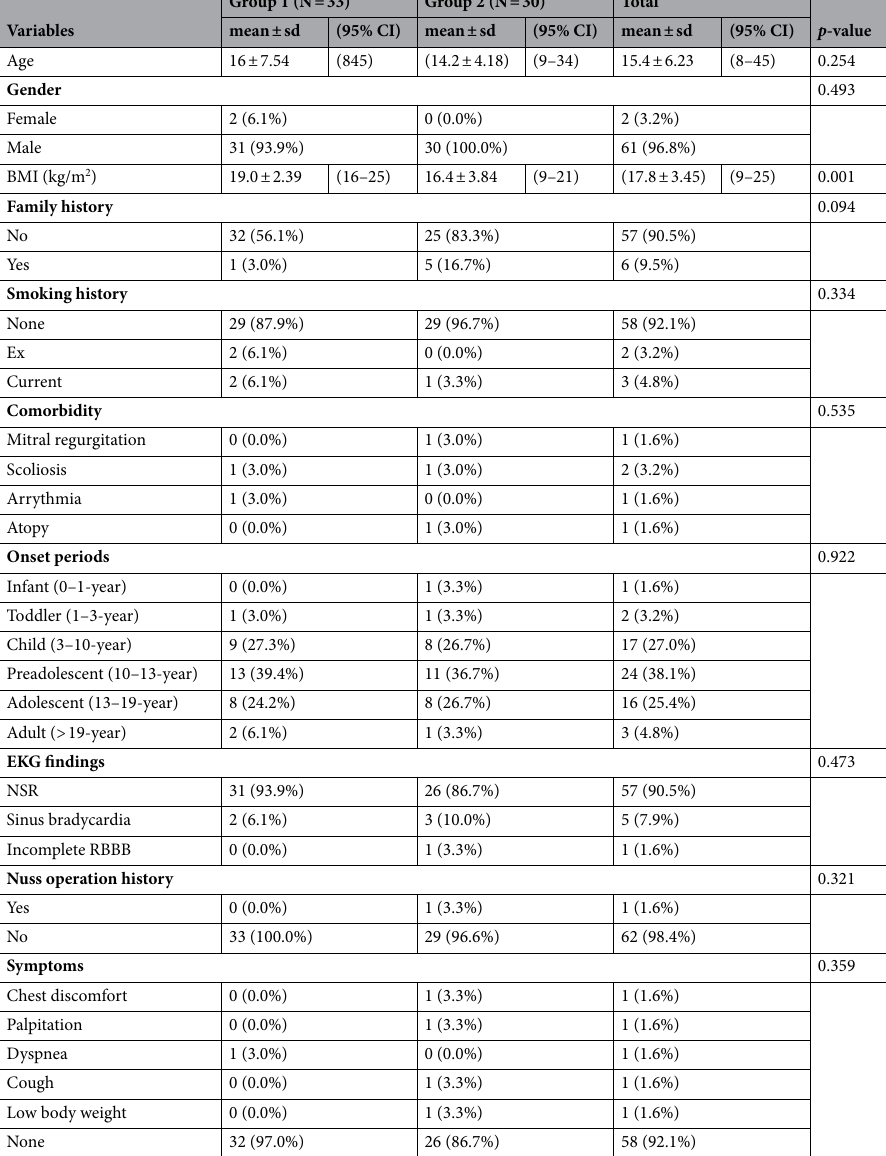
Table 1. Patient characteristics. BMI body mass index, EKG electrocardiography, RBBB right bundle branch block, NSR Normal sinus rhythm, sd standard